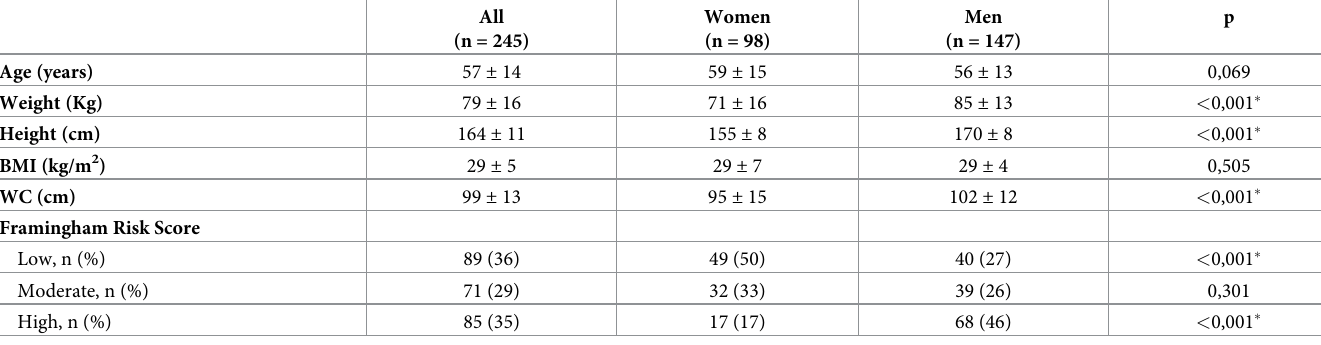
Table 1. Clinical characteristics of subjects included in study.